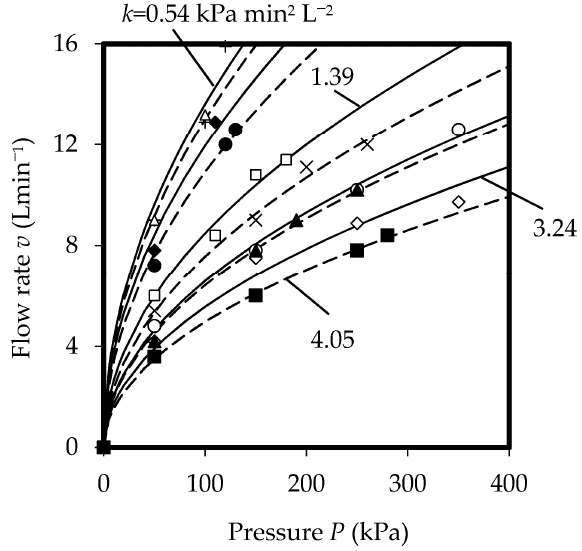
Figure 2. Showerhead resistance factors k for the 10 showerheads surveyed.